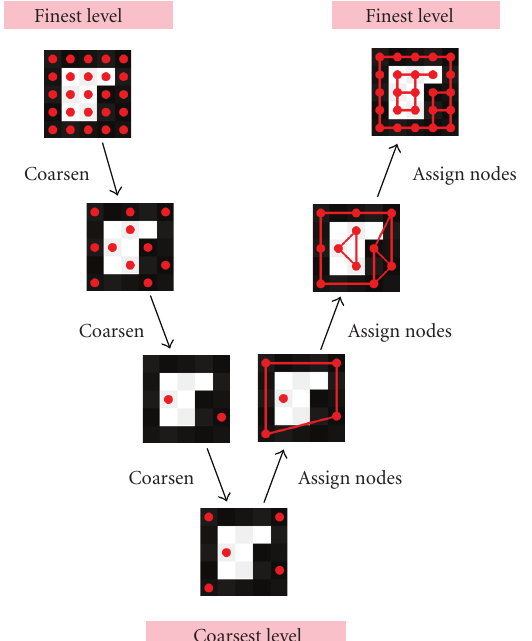
Figure 2: Schematic representation of the SWA algorithm.